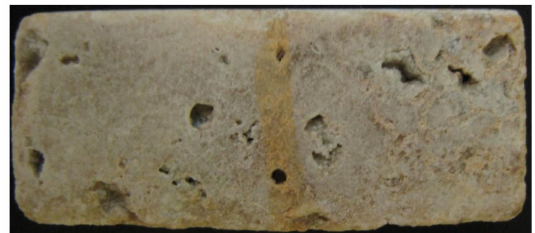
Figure 10. Visual aspect of the coated (left) and uncoated (right) travertine stone.